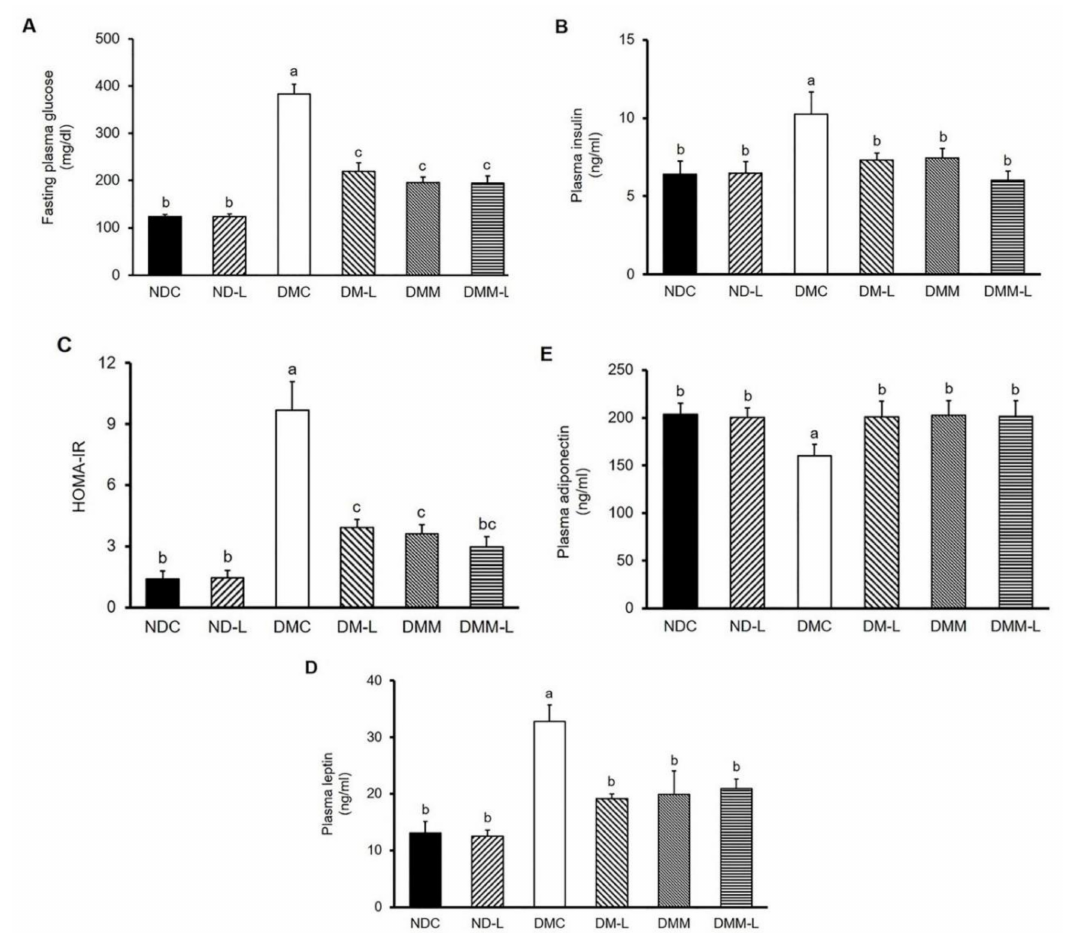
Figure 1. E ff ects of L. paracasei HII01 on the fasting plasma levels of ( A ) glucose, ( B ) insulin, ( C ) HOMA-IR, ( D ) leptin and ( E ) adiponectin in experimental rats. NDC, normal control rats; ND-L, normal control rats supplemented with L. paracasei HII01 (10 8 CFU / day); DMC, diabetic rats control; DM-L, diabetic rats supplemented with L. paracasei HII01 (10 8 CFU / day); DMM, diabetic rats treated with metformin 30 mg / kg; DMM-L, diabetic rats supplemented with combination of L. paracasei HII01 (10 8 CFU / day) and metformin 30 mg / kg; HOMA-IR index, homeostasis model assessment of insulin resistance. All data are expressed as mean ± SEM. Di ff erent lowercase letters indicate significant di ff erences among di ff erent groups ( p <